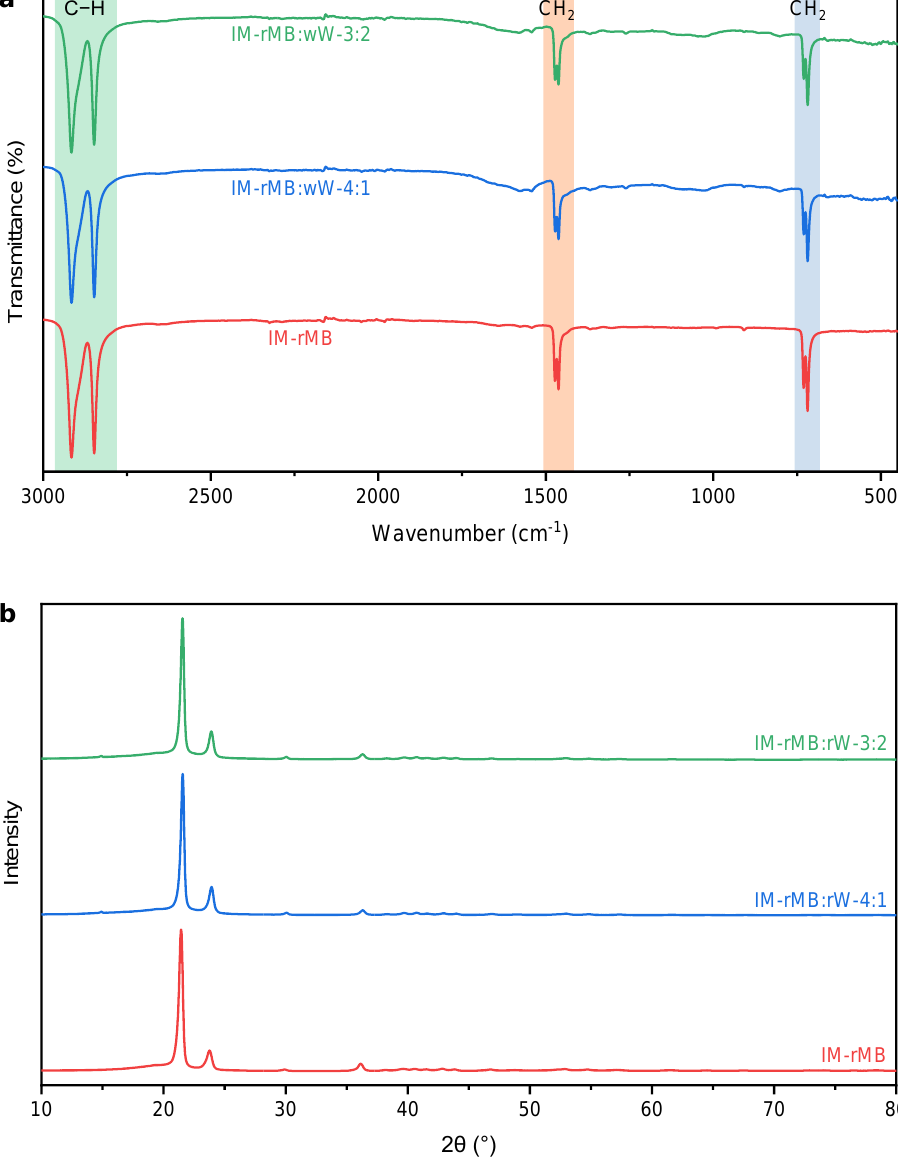
Figure 4. Normalized ( a ) FTIR spectra and ( b ) XRD patterns of the samples.